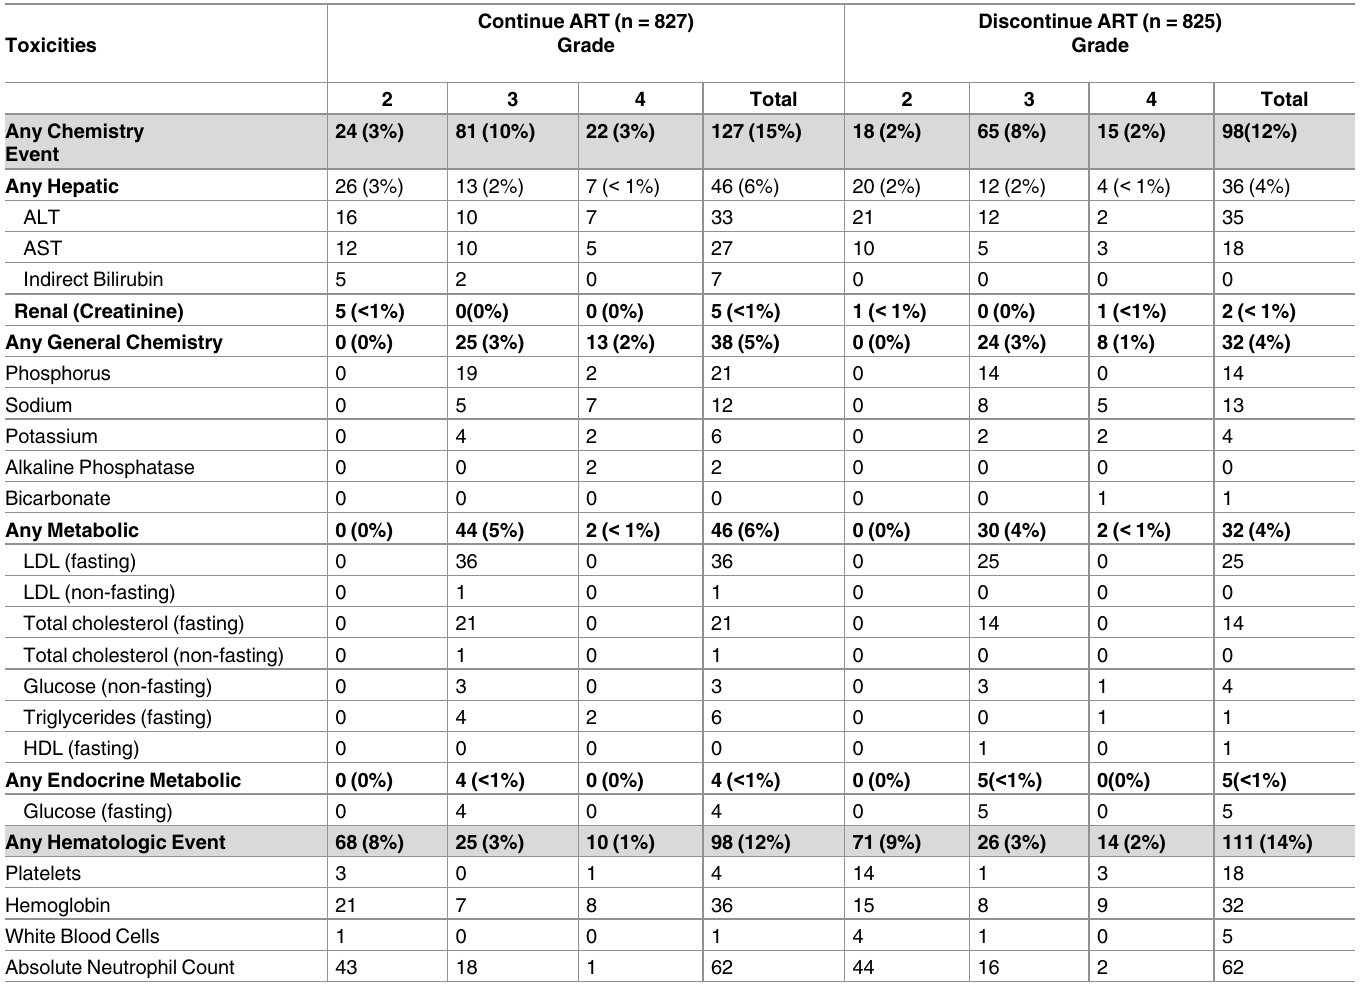
Table 4. Laboratory AdverseEvents a